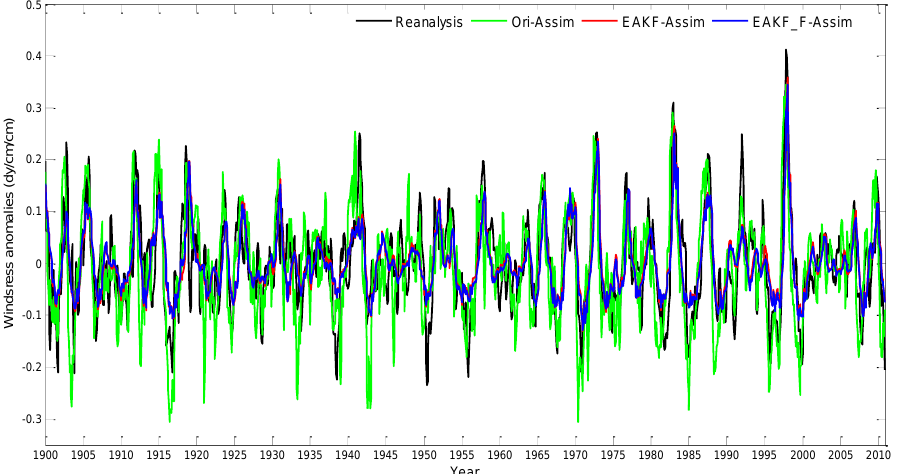
Figure 5. Time series of ZWS anomalies in the Niño3.4 region: ERA-20C reanalysis and simulations from Ori-Assim, EAKF-Assim, and EAKF_F-Assim schemes in black, green, red, and blue lines, respectively.